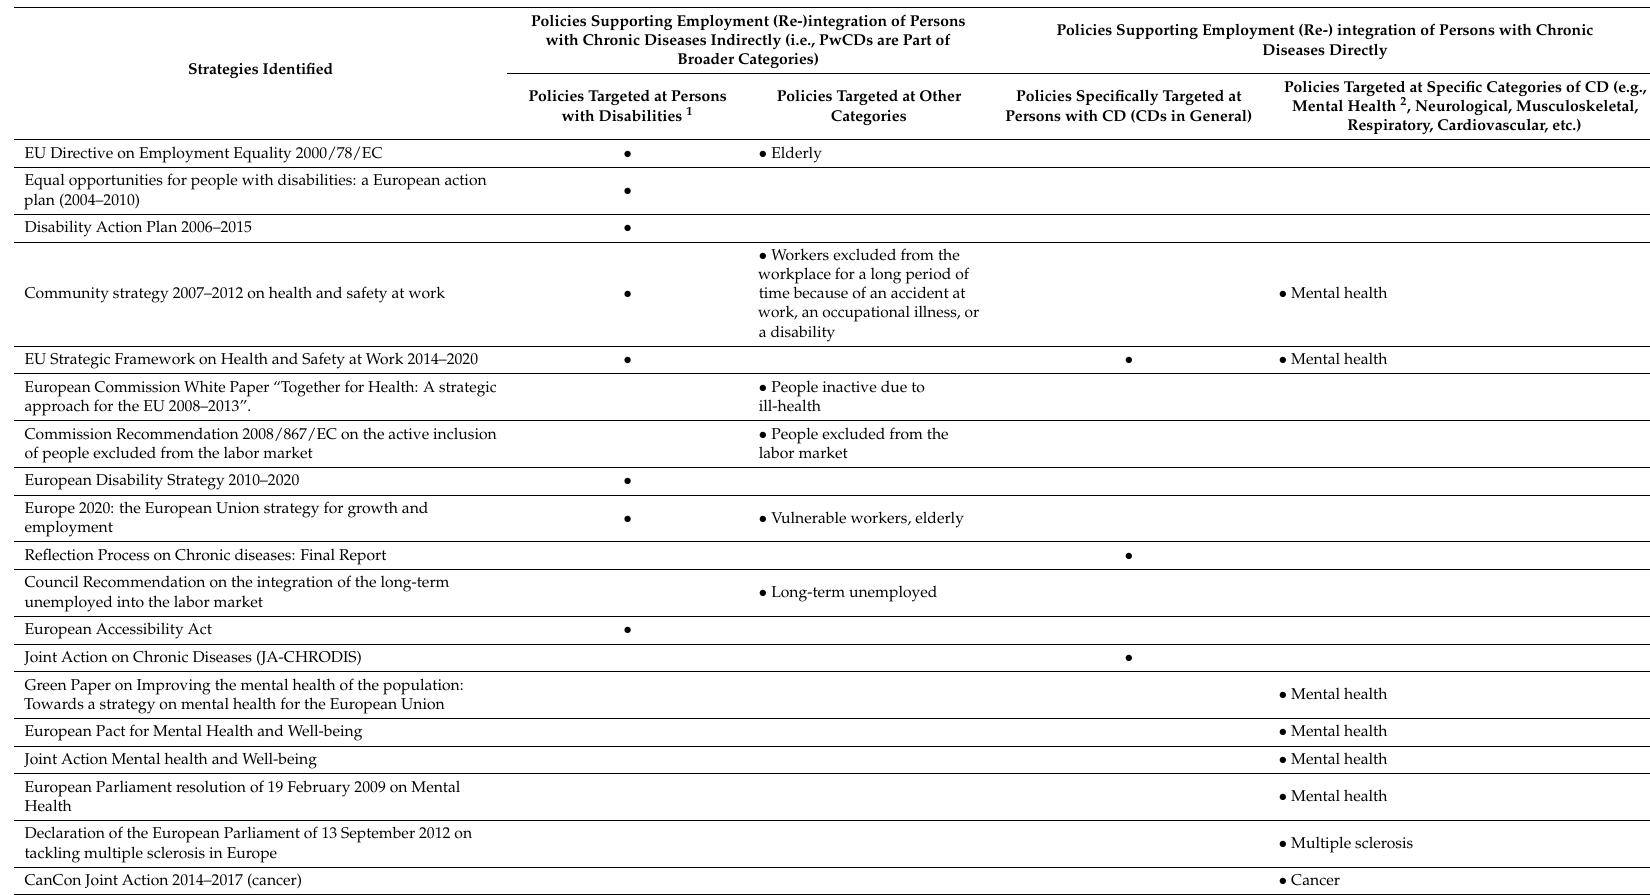
Table 2. European level strategies: policies and their